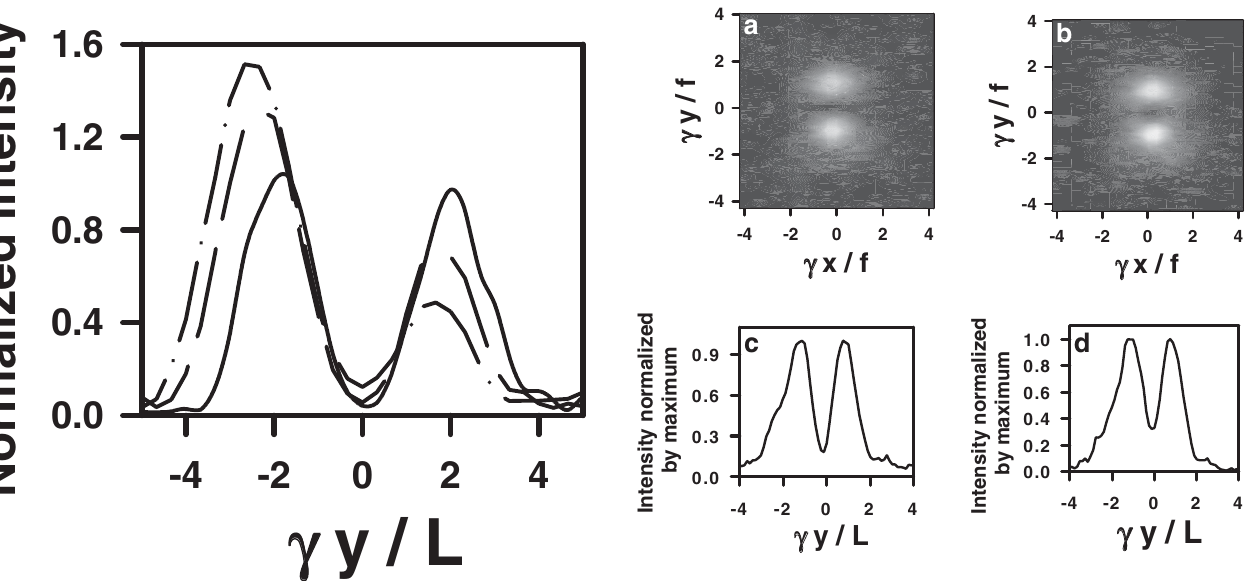
FIG. 23. Three-dimensional spatial distribution of ODR verti- FIG. 22. Projection of ODR vertical polarization component cal polarization component measured with lens and for two measured without the lens for three different electron trajectory electron trajectory offsets with respect to the slit center: (a) (cid:5) 0 —solid line (cid:5) 45 (cid:8) m and its projection onto the y (cid:5) 0 offsets with respect to the slit center: a and (c) are for a s s (cid:5) 45 (cid:8) m —dashed line [Fig. 21(a)]; (cid:5) 80 (cid:8) m and its [Fig. 20(a)]; a plane, respectively; (b) and (d) are for a s s (cid:5) 80 (cid:8) m —dash-dotted line [Fig. 21(b)]. a projection onto the y (cid:5) 0 plane, s